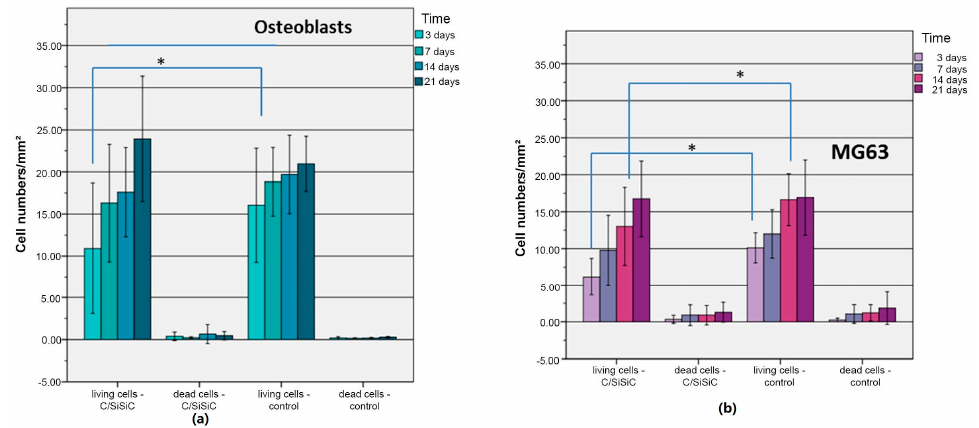
Figure 7. Viability assay with MG 63 for 21 days. ( A – D ): samples (days 3, 7, 14 and 21); ( E – H ): controls (days 3, 7, 14 and 21).